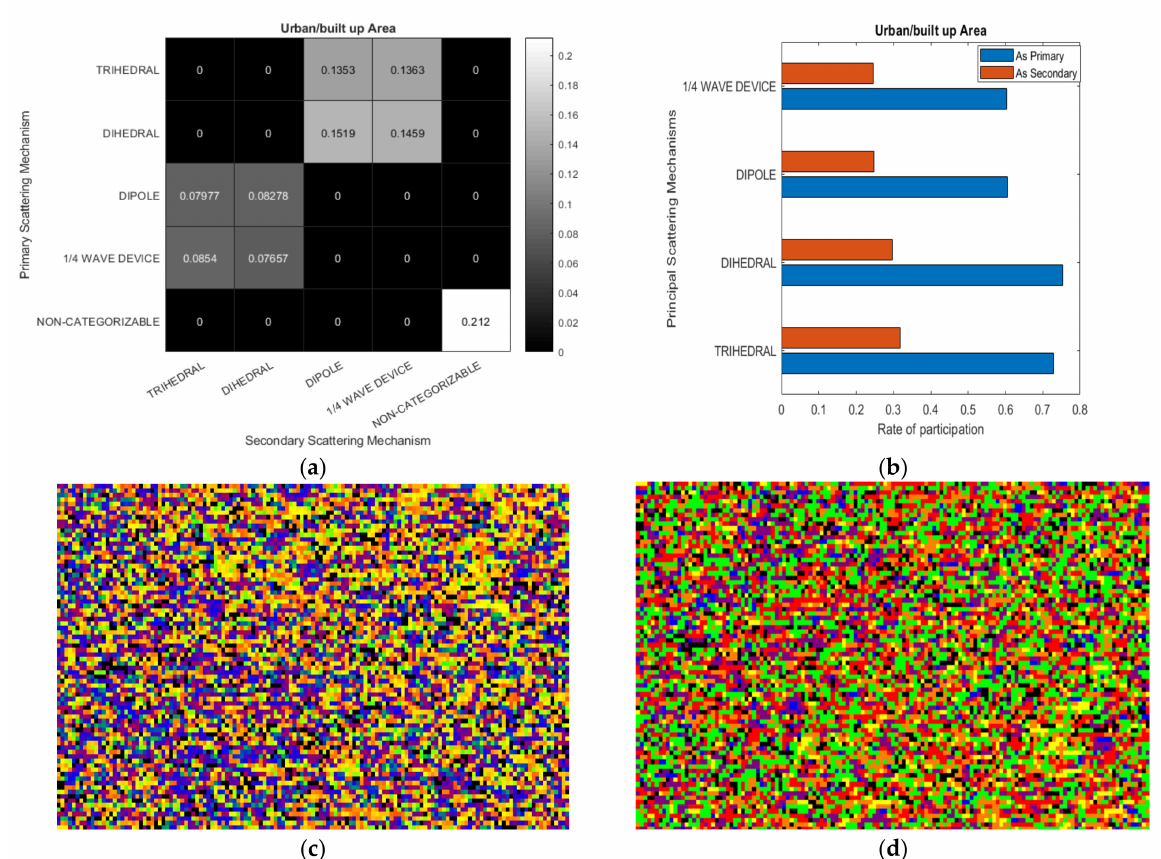
Figure 8. ( a ) heatmap of primary-secondary scattering pairs and bar diagram with ( b ) the rate of contribution (strength) either as primary or secondary scatterer for each mechanism in urban/built up area. ( c ) color representation of each PolSAR cell using the double scatterer method. ( d ) color representation of each PolSAR cell using the Cameron’s CTD method.